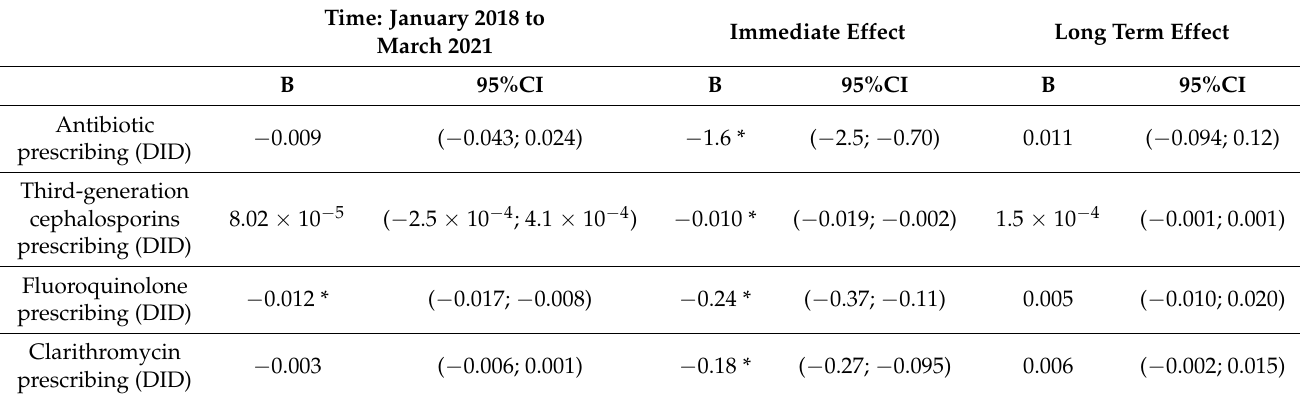
Figure 2. Monthly prescribing trend of antibiotics as DID prescribed in outpatient care. Blue line ( − ): tendency line, after model adjustment; blue dashed line: expected tendency line with no COVID-19 emergence; red dashed line: COVID-19 emergence (March 2020); + : antibiotic monthly prescription in DID. Table 2. Interrupted segmented regression time series analysis of antibiotics prescribing as DID in outpatient care.